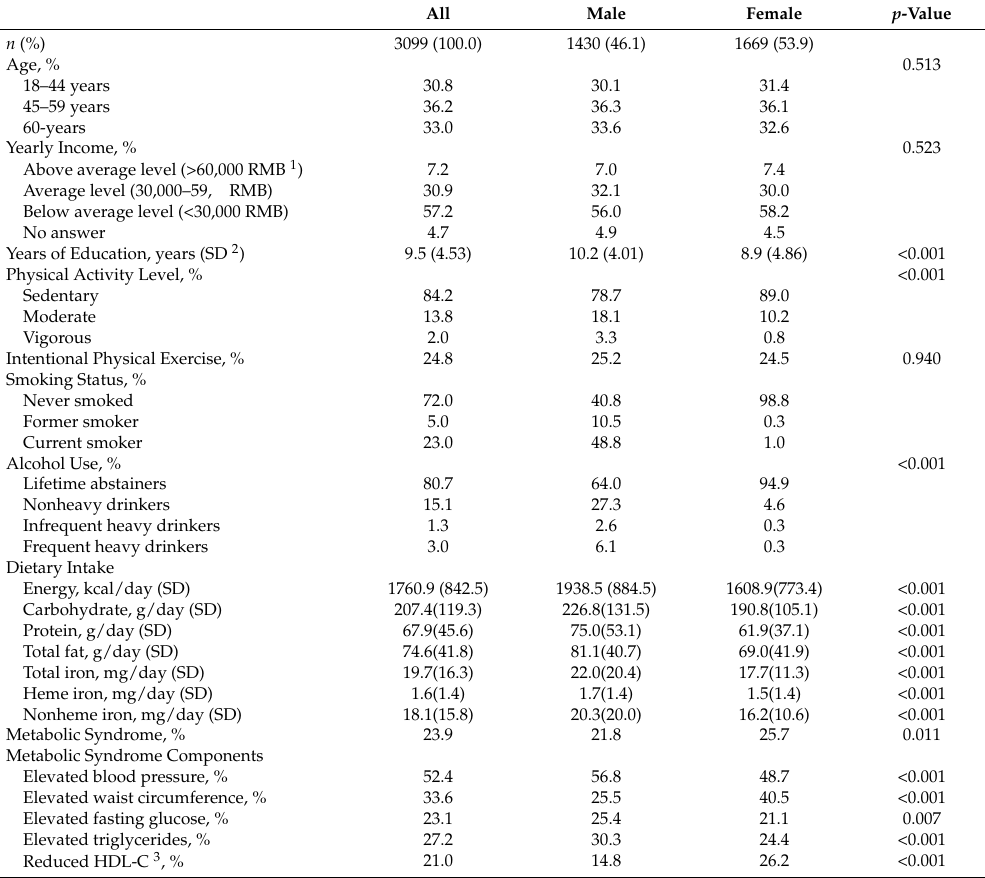
Table 1. Characteristics of the participants by gender in the SDHS 2012–2013. All Male Female p